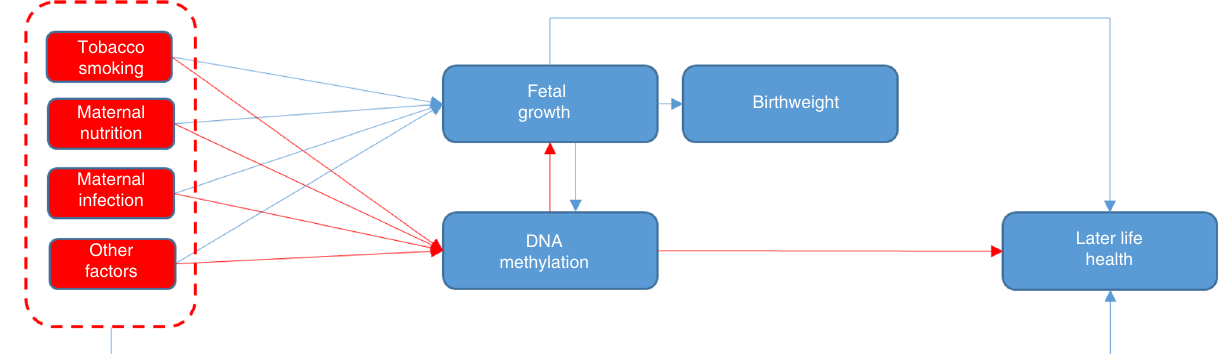
Fig. 1 Hypothetical paths that might link intrauterine exposures to DNA methylation, birthweight and later-life health outcomes. Red arrows summarise the paths that have motivated the analyses undertaken in this study (i.e. that maternal environmental exposures in fl uence DNA methylation that in turn in fl uences fetal growth and hence birthweight). The EWAS meta-analysis undertaken sought to identify methylation associated with birthweight. Blue arrows summarise other plausible paths, including that maternal exposures in fl uence fetal growth fi rst and it then in fl uences DNA methylation or that maternal exposures may in fl uence fetal growth/birthweight and later-life health outcomes through other pathways than DNA